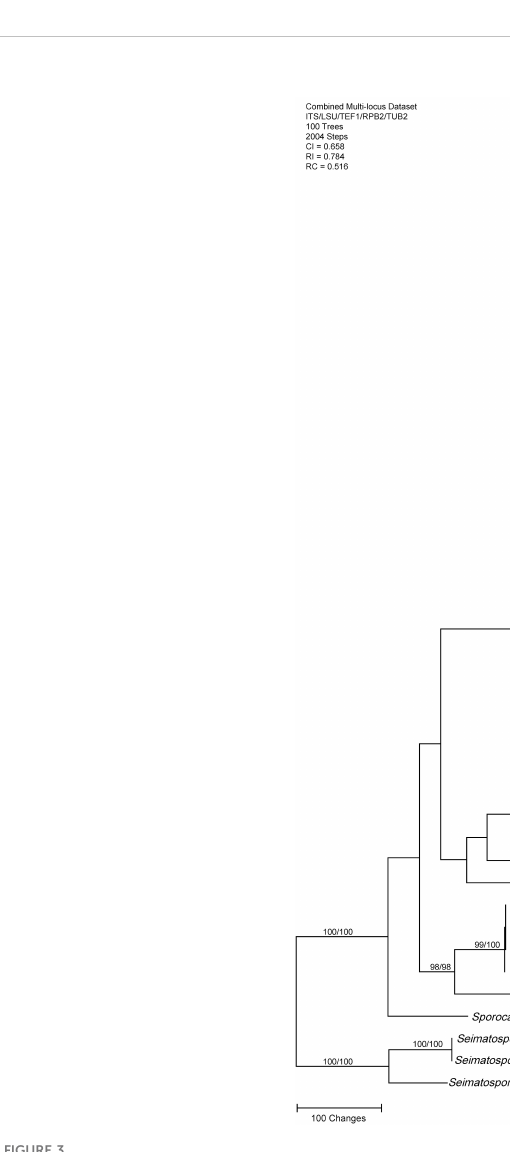
FIGURE 3 Phylogram generated from maximum parsimony analysis of the genus Sporocadus based on a combined ITS, LSU, TEF-1 a , RPB2, and TUB sequence dataset. Bootstrap support values for MP and ML equal to or greater than 70% are presented. The tree is rooted to Seimatosporium luteosporum (CBS 142599 and Napa754) and Seimatosporium pistaciae (CBS 138865). The new isolates are in bold and isolates of new species are in blue. Ex-type strains are noted with superscript